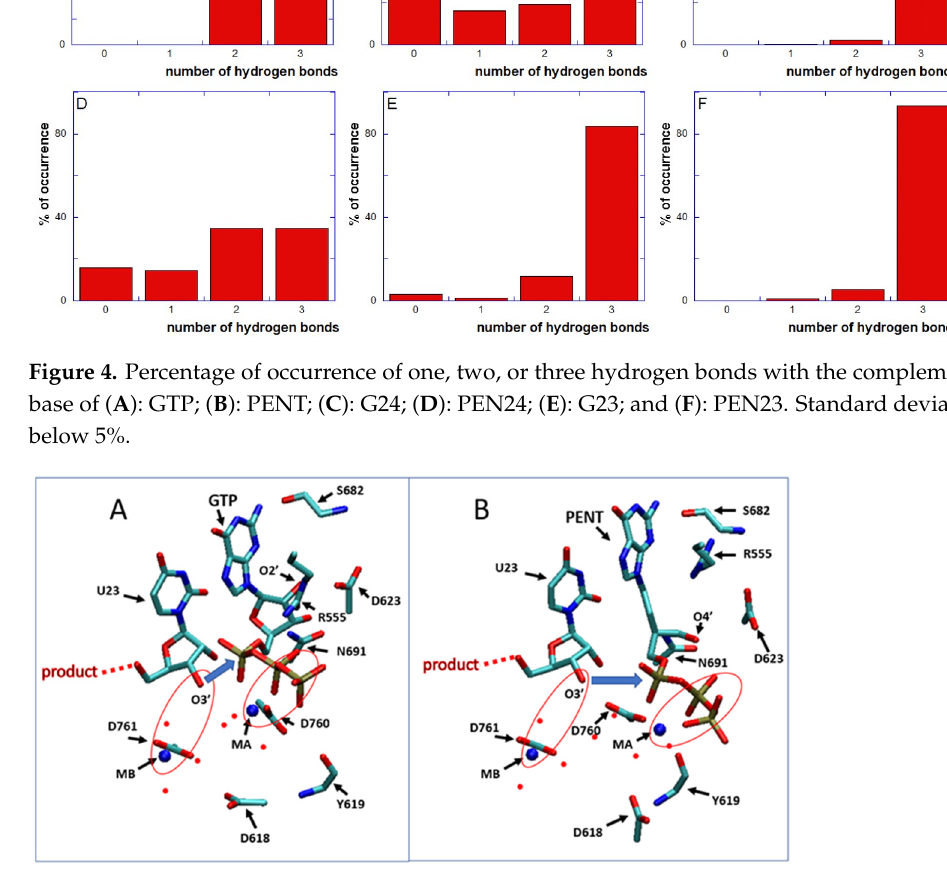
Figure 5. Images of active site of the complex in the presence of ( A ): GTP or ( B ): PENT. For clarity, except for S682 and Y619, only the side chains of amino acids are shown. Red bullets are the oxygen of water molecules surrounding ions. Images have been obtained by VMD software.